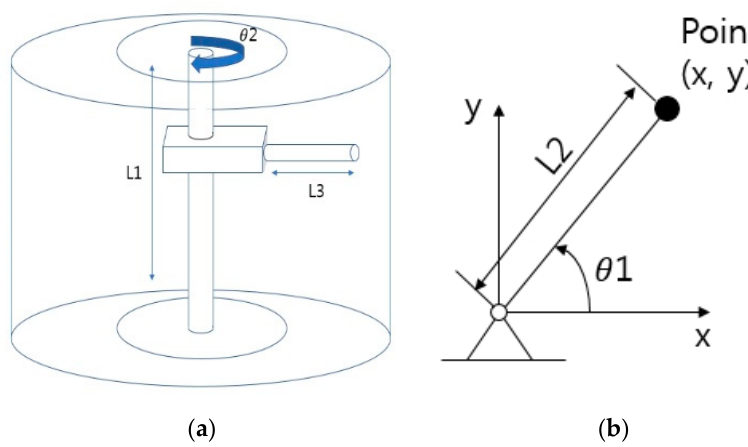
Figure 1. Coordinate relationship of the manipulator used in this study: (a) three axes (rotation, horizontal, vertical); (b) two axes ignoring vertical orientation.